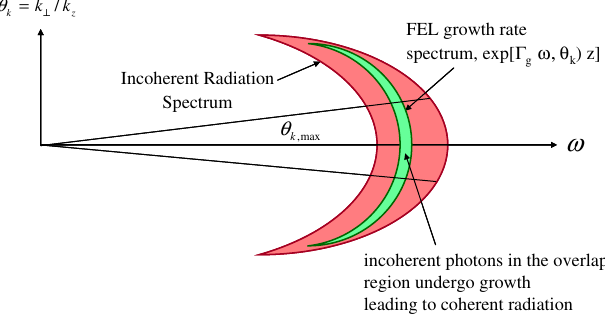
FIG. 5. (Color) Schematic diagram of the incoherent (sponta- neous) and coherent (growth rate) spectrum in the ð !; k ? =k plane showing the region of overlap. The red area corresponds to the region of incoherent emission of radiation from the electron beam interacting with the pump laser. The green area indicates the growth rate spectral region in which the radiation grows